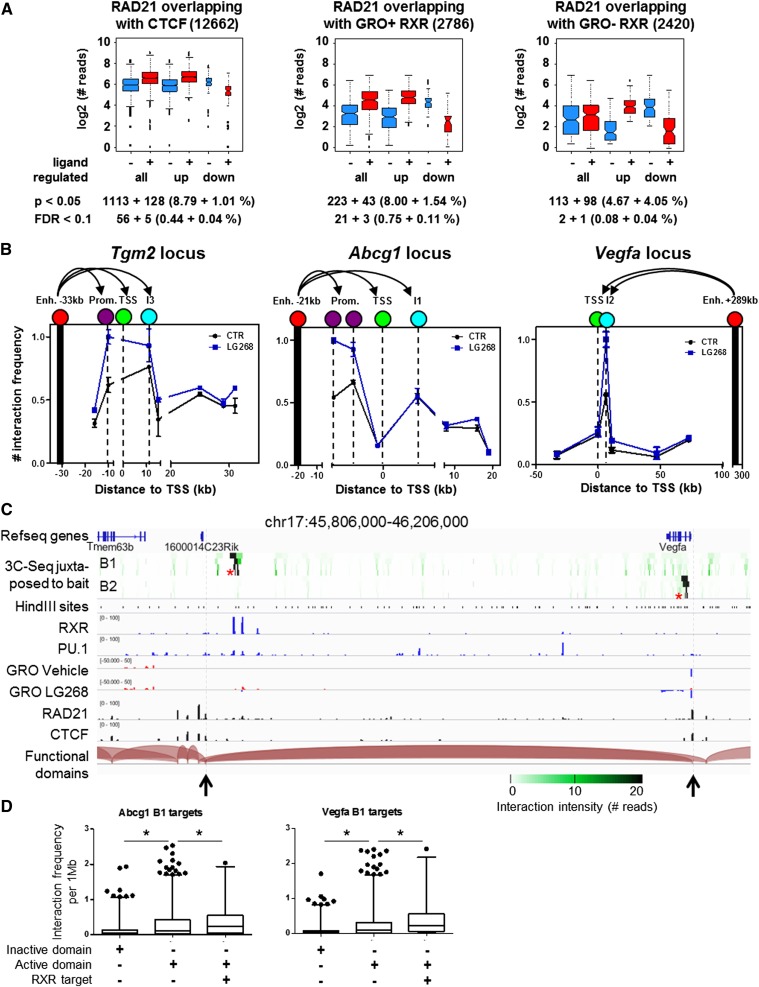
Functional characterization of short- and long-range liganded RXR-regulated enhancers. (A) Changing RAD21 peaks in the presence of 100 nM LG268 on CTCF-binding sites (left) and GRO-seq-positive (middle) and GRO-seq-negative (right) RXR-binding sites. The log2-normalized read numbers of the significantly changing peaks are plotted. The number of changing peaks and the statistical stringency applied are indicated below each plot. (B) 3C-RT-qPCR measurements in the presence or absence of LG268 on the Tgm2, Abcg1, and Vegfa loci. Constant primers were designed to the enhancers and are represented by black columns (anchor points). Red circles represent the enhancers, purple ones are the promoter regions, TSSs are depicted with green, and intronic regions are highlighted by cyan circles. The mean and ±SD of triplicate determinations are shown. Representative examples are shown for each locus. (C) Genome browser view of the Vegfa locus containing the proximal interacting regions of the intergenic (B1) and intronic (B2) baits and the loop predictions generated based on CTCF/RAD21-cobound regions. 3C-seq heat map (green scale) was made as described in the Supplemental Material. Asterisks show the sites of the specific baits. GRO-seq and ChIP-seq for the indicated factors are shown. Black arrowheads and gray dashed lines indicate the predicted domain borders. (D) Box plot representation of the distribution of interaction frequency of Abcg1 B1 enhancer (chr17: 31,172,998–31,173,656) and Vegfa B1 enhancer (chr17: 45,890,060–45,890,829) determined by 3C-seq. The interchromosomal interactions of these enhancers were determined as described in the Supplemental Material. The detected interactions were mapped onto 1-Mb fragments covering the mouse genome. Interaction frequency was determined by expressing the read number per 1 Mb normalized to 1000 reads. Genome regions (inactive, active, and RXR target) were qualified as described in the Supplemental Material. Unpaired two-tailed t-test analysis was used to determine significant differences. Asterisk represents significant difference at P < 0.0001.